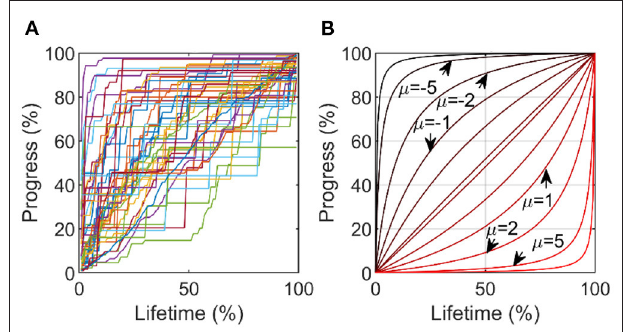
FIGURE 3 | Estimating steadiness of use. (A) % Progress in exercises achieved vs. % lifetime. (B) We fit curves of this form, identifying the parameter µ as the “steadiness curvature.” A curve with µ use over the lifetime, while a curve with µ tapering rapidly off (deceleration), and a µ increasing